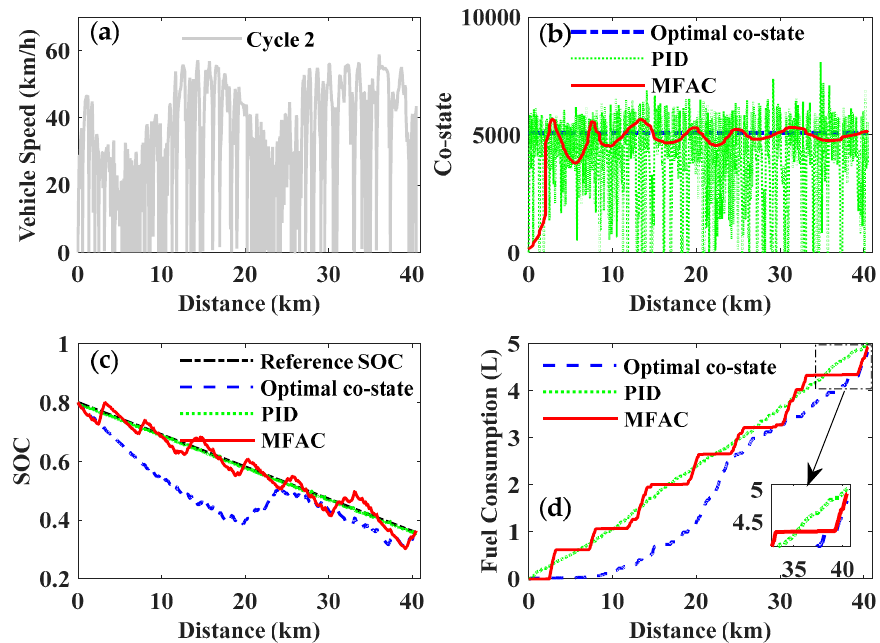
Figure 19. The simulation results of driving Cycle 2. ( a ) Driving cycle; ( b ) Co-state; ( c ) SOC; ( d ) Fuel consumption.